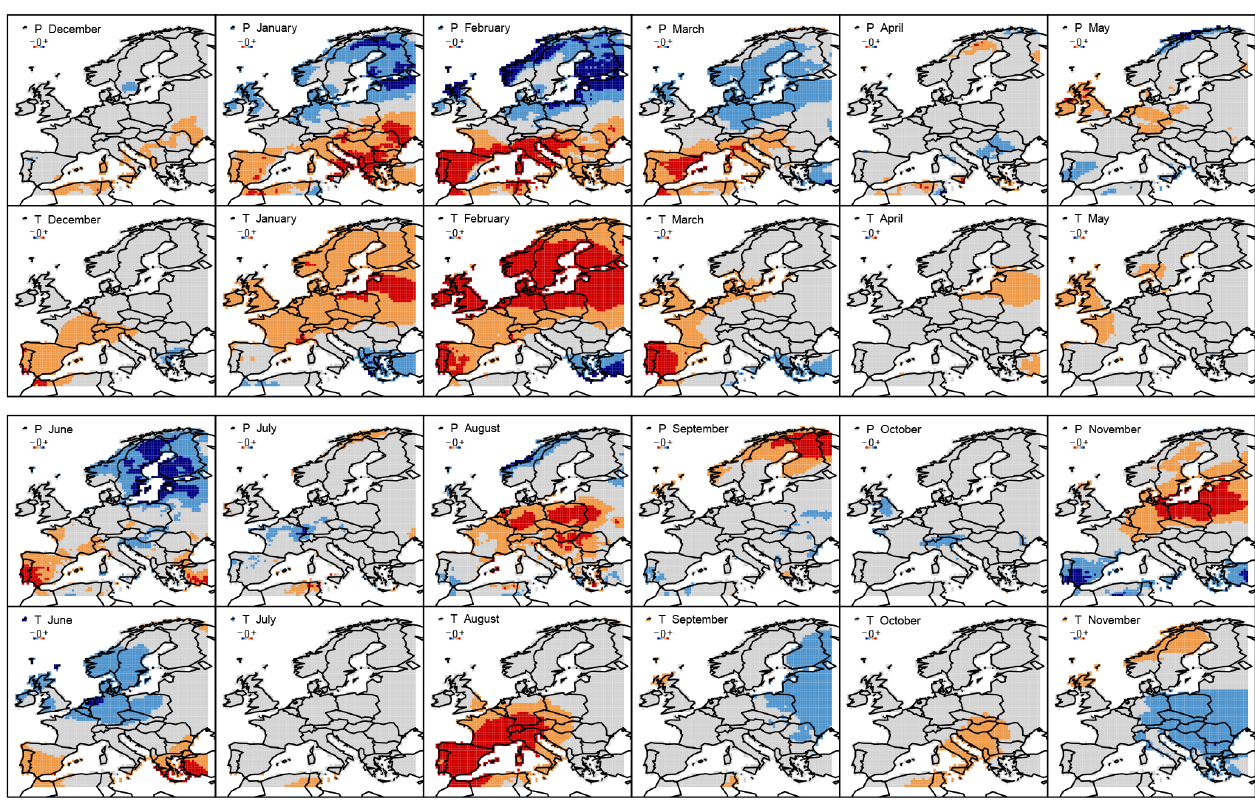
Figure 1. Synoptic-circulation-induced trends for precipitation (rows 1 and 3) and temperature (rows 2 and 4) significant at the 70% (light colours) and 95% (dark colours). Precipitation: increasing trends in blue, decreasing trends in red. Temperature: increasing trends in red, decreasing trends in